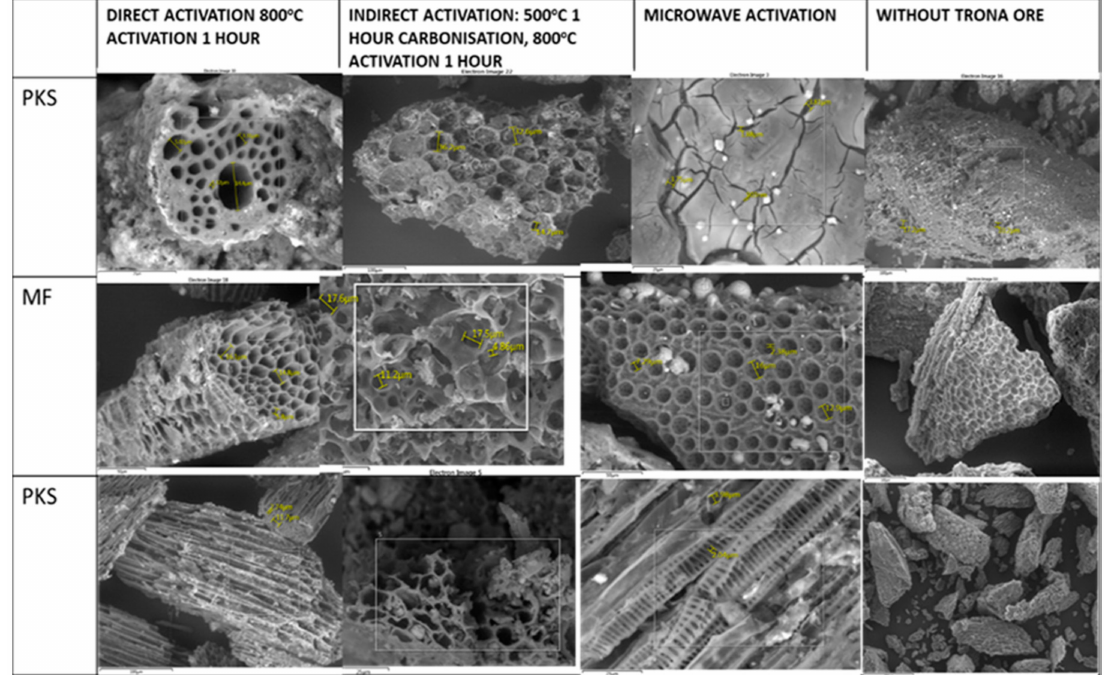
Figure 3. SEM analysis of the AC produced from